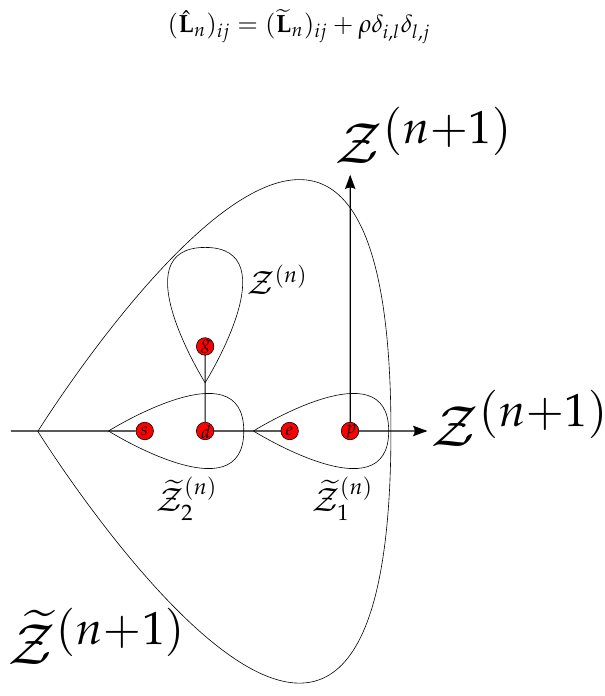
Figure 11. composition of an internal Figure A1. Composition of an internal